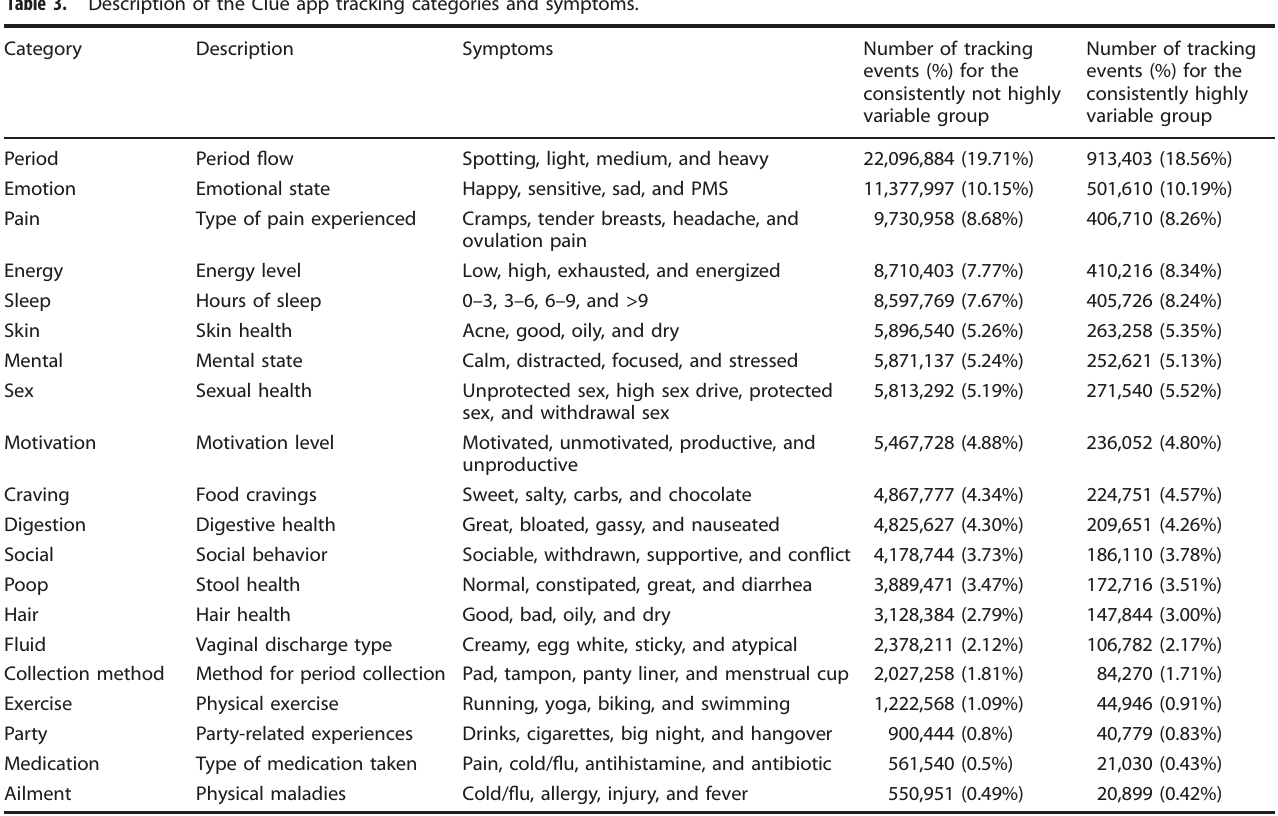
Table 3. Description of the Clue app tracking categories and